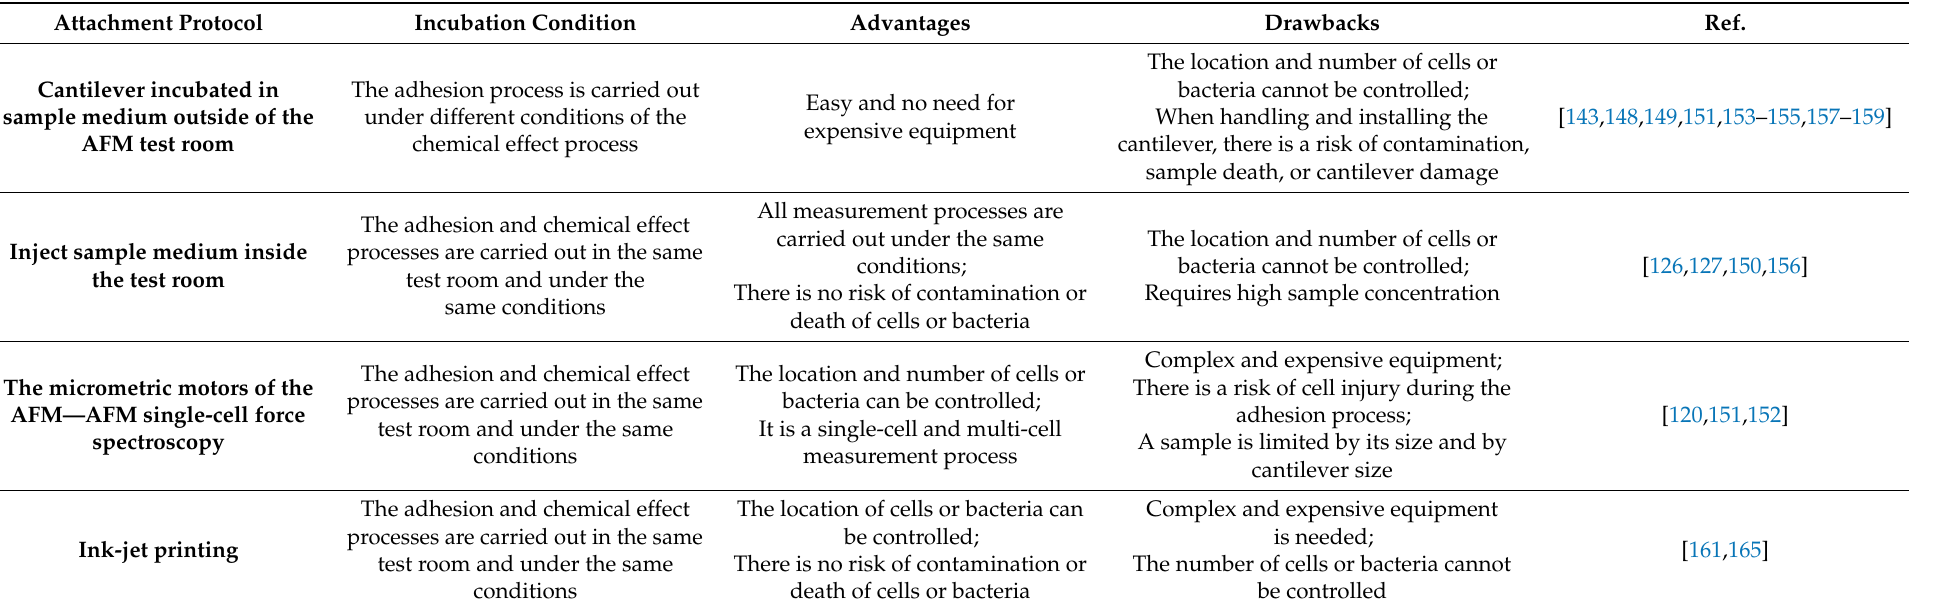
Table 2. AFM nonomotion living sample attachment